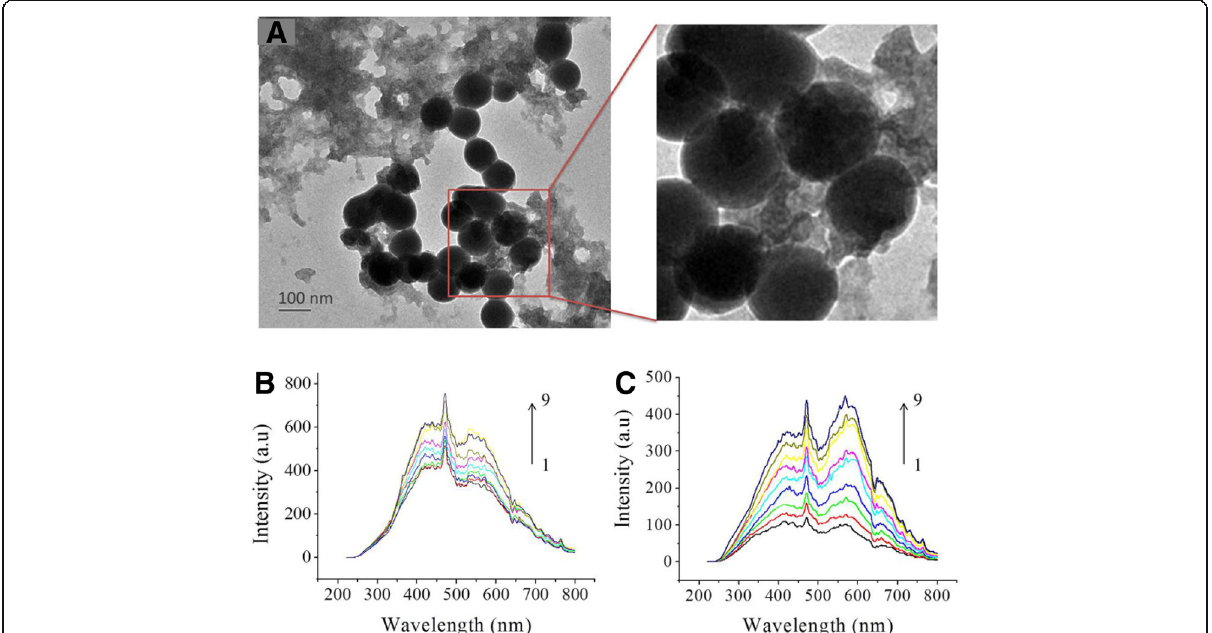
Fig. 4 Affinity of CGA@SeNPs for A β 40. a The binding capacity of CGA@SeNPs on A β 40 fibers. The performed fibers of A β 40 were incubated with CGA@SeNPs and examined on TEM. A β 40 = 35 μ M, CGA@SeNPs = 60 μ g/mL. b Affinity and specify of CGA@SeNPs for A β 40 monomer. The RLS spectra of A β 40 monomer in the presence of different concentration of CGA@SeNPs. A β 40 = 600 nM, nanoparticles concentration, 1 – 9: 0, 0.05,